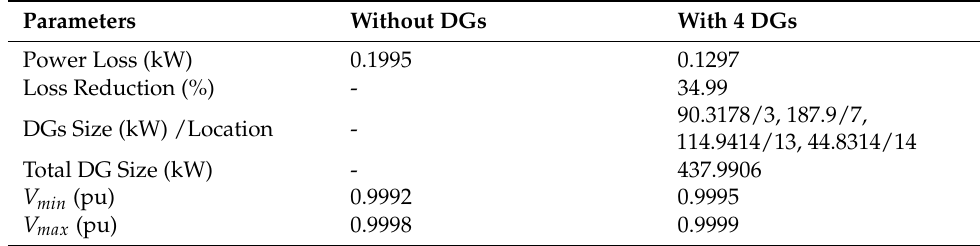
Table 2. Simulation results for 14-bus